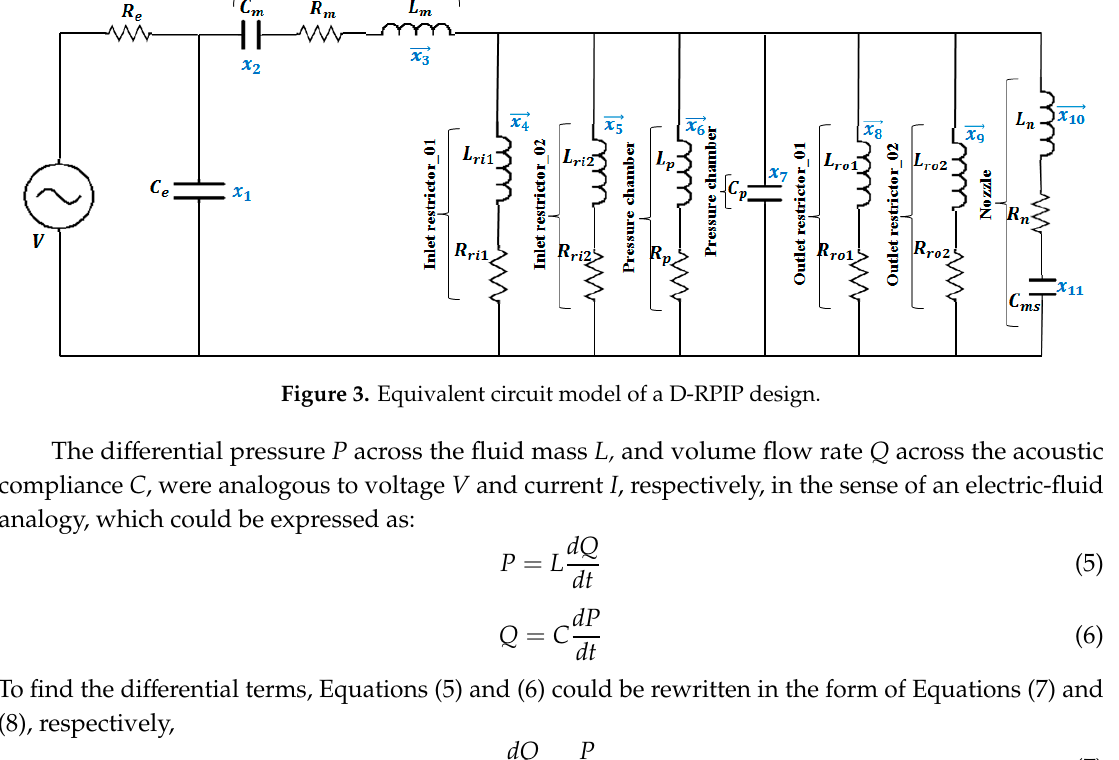
Table 4. Ink properties used in lumped element model (LEM) and FEM simulations.